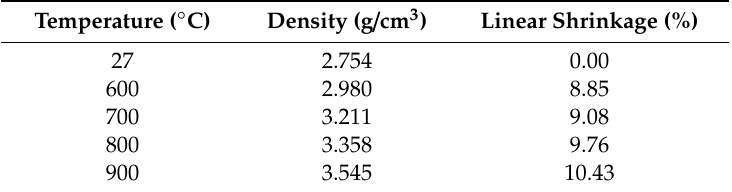
Table 1. The variation of bulk density and linear shrinkage of the 55ZnO–5B 2 O 3 –40SLS glass and glass-ceramic sample at various heat-treatment